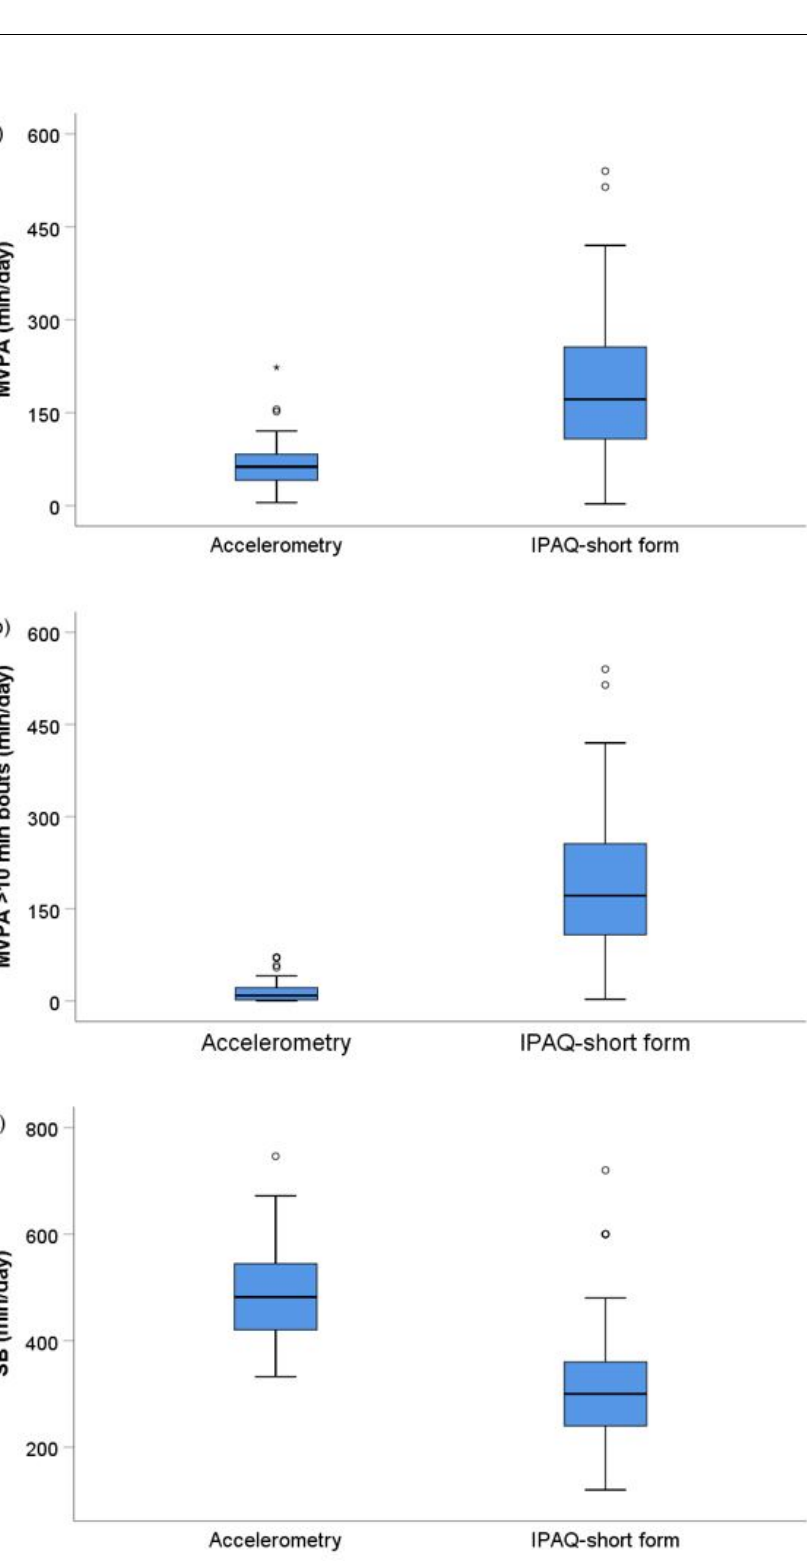
Figure 3. Differences between objectively and subjectively measured MVPA ( a ), daily MVPA bouts > 10 min ( b ) and SB ( c ). MVPA—moderate to vigorous physical activity; SB—sedentary behavior, IPAQ-short form—international physical activity questionnaire short form. Data are presented in boxplots. Circles and stars present outliers.